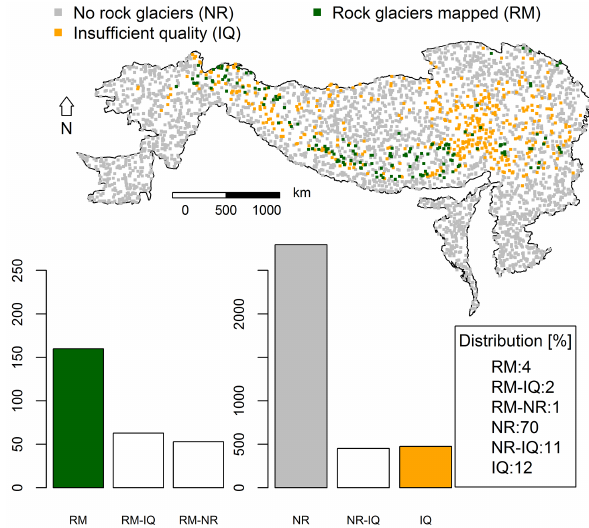
Figure 3. Overview of mapping results. All 3432 samples with the same classification from both mappings are shown. In the bar plots, identically classified samples are shown with filled bars and samples, which were classified differently in white. Bars with only one abbreviation (e.g., RM) mean that both mapping persons had the same classification of the sample (e.g., rock glacier mapped), whereas two abbreviations (e.g., RM-IQ) mean that the mappings resulted not in the same classification (once rock glacier mapped, once insufficient quality). Note that the difference in scale between the samples containing rock glaciers on the left and all others sam- ples on the right is 1 order of